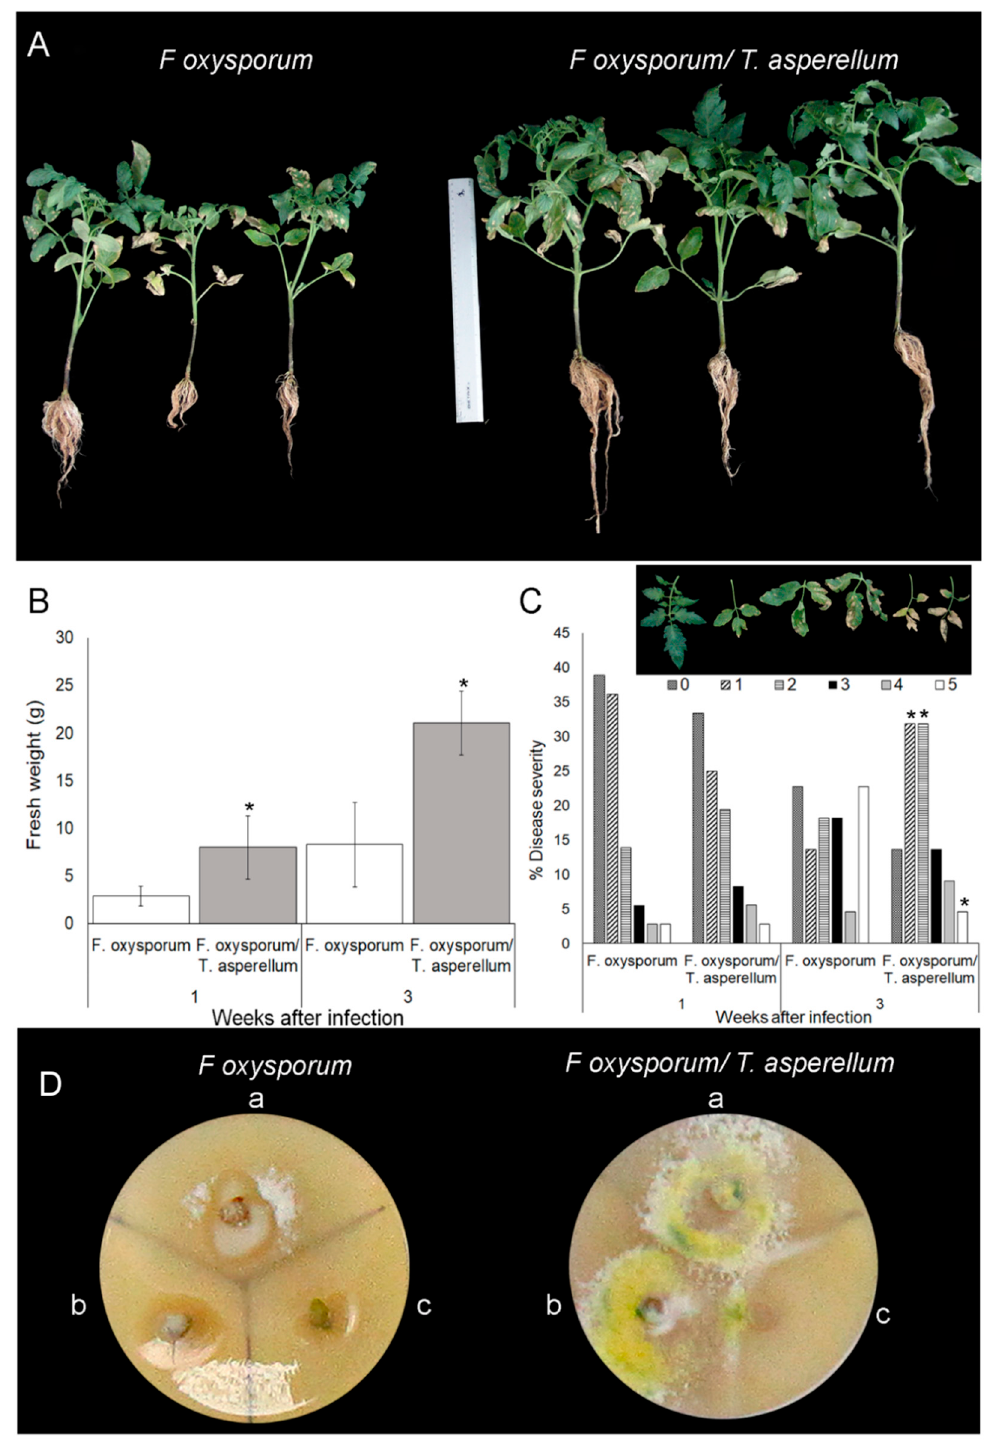
Figure 2. Trichoderma asperellum reduces Fusarium severity on tomato plants. ( A ) Fusarium oxysporum wilt and stunting symptoms on T. asperellum non- and preinoculated tomato plants after 3 weeks post infection. ( B ) Fresh weight was recorded at 1 and 3 weeks post-inoculation. ( C ) Disease severity (%) scores represent the number of leaves showing different levels of wilt symptoms shown in the upper panel in reference of total number of leaves of each plant. Symptoms were recorded at 1 and 3 weeks after infection. ( D ) Stem section were cut from cotyledon node (a), second node (b) and third node (c) of individual tomato plants non- and preinoculated with T. asperellum and infected after 3 weeks. Photographs were taken 5 days after incubation of nodes on PDA. Asterisks indicate significant differences among treatments at a given time ( p ≤ 0.05), error bars indicate SEM.